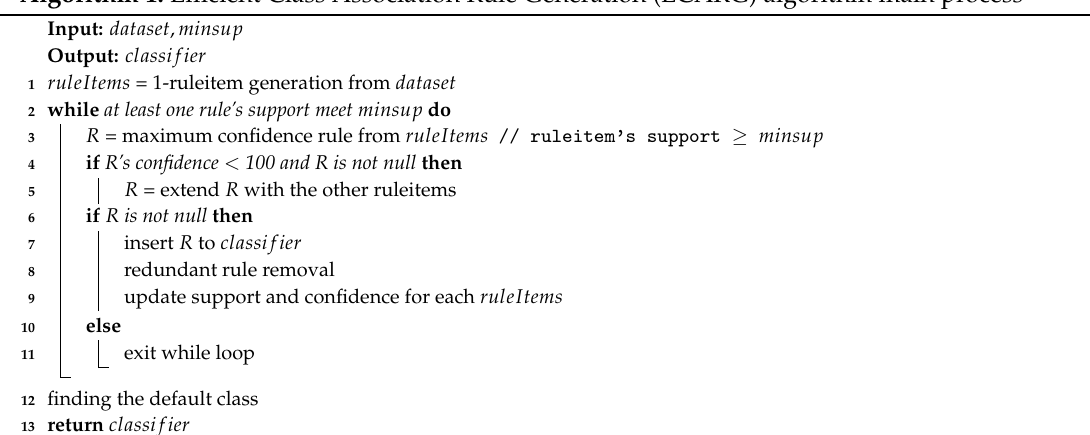
Algorithm 1: Efficient Class Association Rule Generation (ECARG) algorithm main